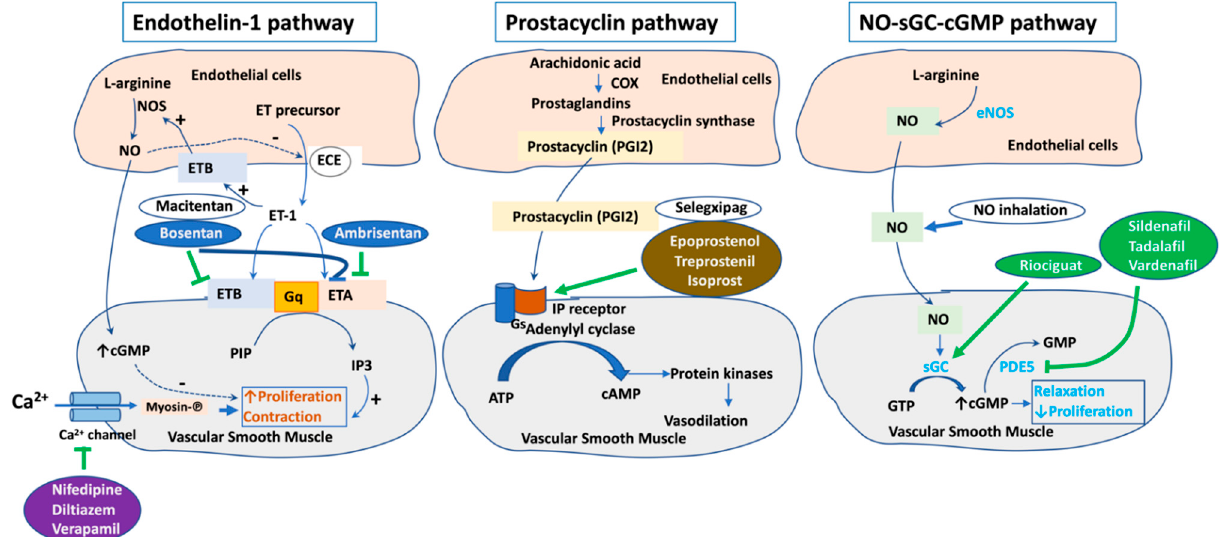
Figure 2. Current therapeutic target pathways for PAH. The endothelin-1, prostacyclin, and nitric oxide pathways have been exploited in clinical therapeutics. These three pathways are critical pathways approved for PAH treatment. Abbreviations: NO, nitric oxide; NOS, nitric oxide synthase; eNOS, enthothelial nitric oxide synthase; GC, guanylyl cyclase; PDE5, phosphodiesterase type 5; GMP, guanosine monophosphate; cGMP, cyclic guanosine monophosphate; GTP, guanosine triphosphate; ET-1, endothelin-1; ETA, endothelin A; ETB, endothelin type A; ECE, endothelin converting enzyme; PIP, phosphatidylinositol phosphate; IP3, inositol 1,4,5-trisphosphate; COX, cyclooxygenase; ATP, adenosine triphosphate; cAMP, cyclic adenosine monophosphate.